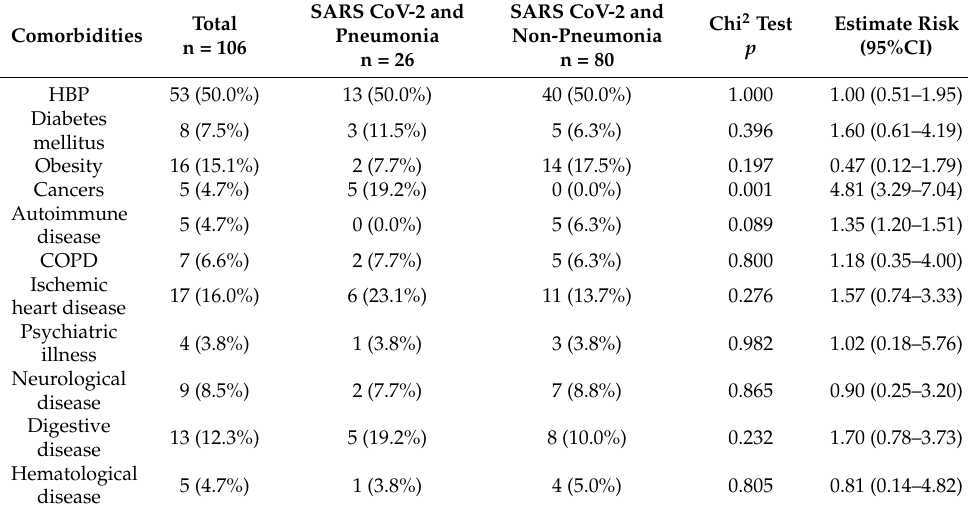
Table 4. Risk factors in SARS CoV-2 patients with pneumonia according to personal pathological history.